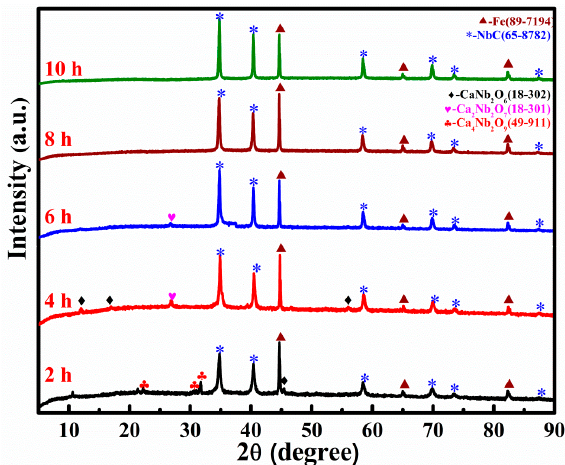
Figure 2. XRD patterns of the samples electrochemically reduced from the Nb 2 O 5 /Fe/carbon composite pellets under 3.0 V for various durations at 900 °C.